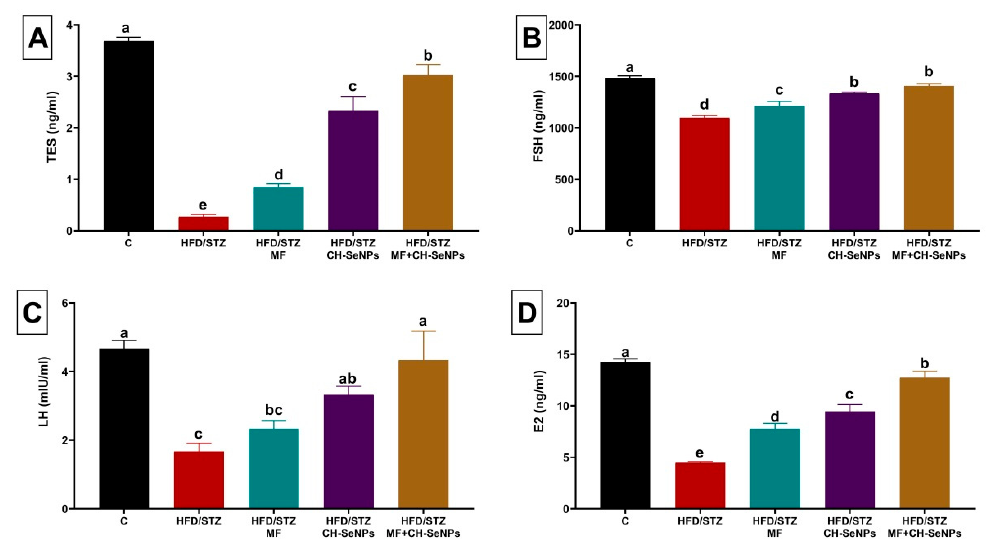
Figure 2. Effect of metformin (MF) and/or chitosan stabilized nanoparticles (CH-SeNPs) oral dosing for 60 days on sexual hormonal variables including ( A ) testosterone (TES), ( B ) follicle-stimulating hormone (FSH) ( C ), luteinizing hormone (LH), and ( D ) estradiol (E2) levels in the serum of HFD/STZ diabetic male rats. Data are expressed as mean ± SE, n = 15 for each group. Each bar carrying different letters (a, b, c, d and e) was significantly different at p < 0.05.